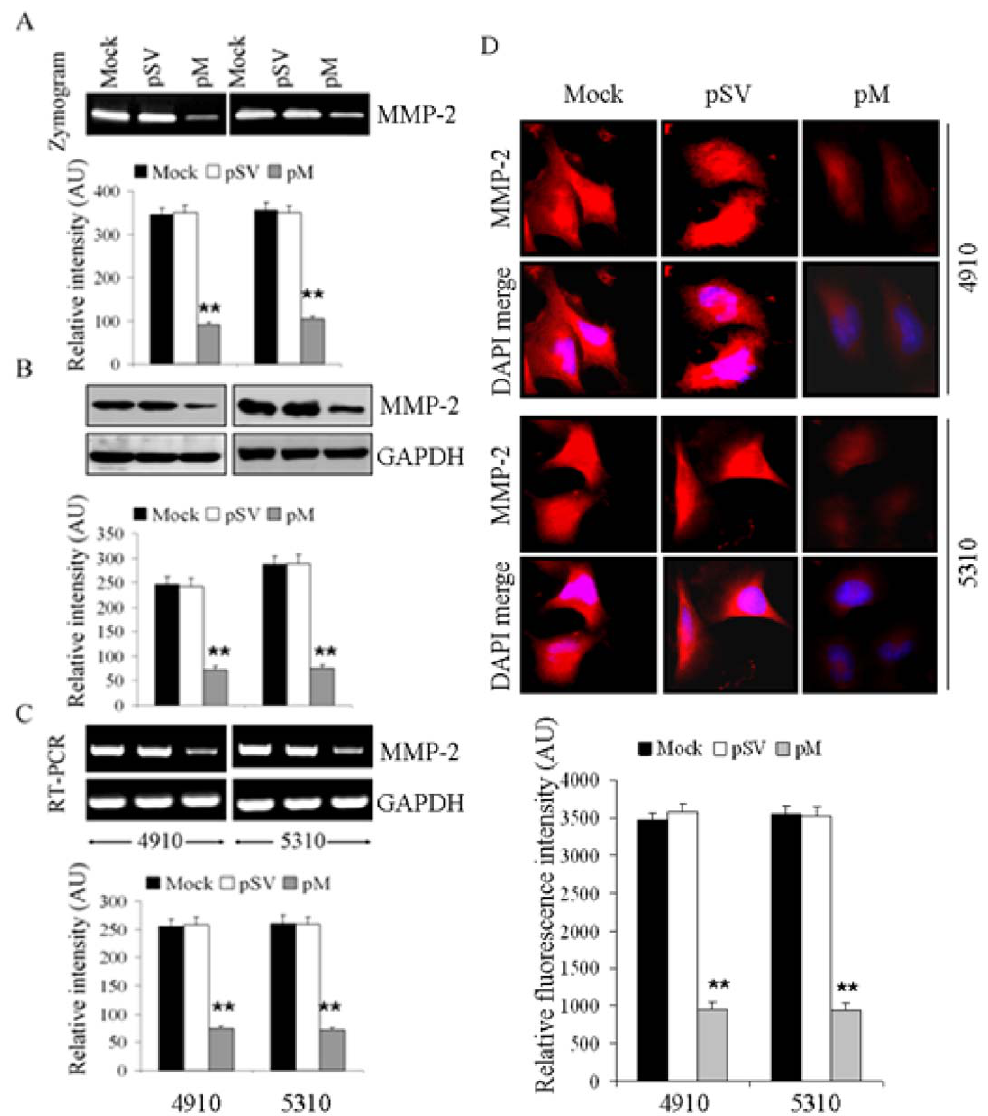
Figure 1. Effect of RNA interference on MMP-2 expression in human xenograft cell lines 4910 and 5310. Different treatments included control (mock), pSV (scrambled vector), pM (pMMP-2Si, pcDNA3.1 vector containing siRNA sequence for MMP-2). A. Gelatin zymography of extracellularly secreted MMP-2 in to tumor conditioned medium at 72 h post-transfection. The bar diagrams below represent the quantification of gelatinolytic band intensities in 4910 and 5310 cells with mean 6 SE of at least three individual experiments. B. Western blotting showing protein expression levels in mock, pSV and pM treatments. At 72 h post-transfection, cells were harvested and whole cell lysates were prepared using RIPA buffer. The representative blot of three different repetitions is shown. The blot was stripped and re-probed with anti-GAPDH antibody, which served as a loading control. The following bar diagram shows relative expression levels of MMP-2 protein with different treatments. C. Semiquantitative RT- PCR shows transcriptional levels of the MMP-2 gene and GAPDH was as a loading control. Band intensities were quantified using ImageJ 1.42 software (NIH Bethesda, USA) and the arbitrary units were plotted using mean 6 SE of at least three individual repetitions. D. Immunofluorescence study using blinded analysis showing the expression of MMP-2 in mock, pSV- and pM-treated 4910 and 5310 cells at 72 h post-transfection. After the treatments, cells were fixed in 4% paraformaldehyde, incubated with anti-MMP-2 antibody followed by Alexa Fluor H secondary antibodies, and observed under confocal microscopy. DAPI was used for nuclear counterstaining. Cells in randomly selected microscopic fields in three individual repetitions were represented where the fluorescence intensity was quantified using ImageJ and the arbitrary fluorescence units were plotted as mean 6 SE. The significant difference among different treatments in above experiments was represented by ‘‘**’’, at p , 0.01. cells was plotted in Fig. 2E, which shows up to 57.3 6 4.6% and 56.8 6 5.0% of the pM-transfected 4910 and 5310 cells were TUNEL-positive as compared to that of mock-treated (3.2 6 0.5% and 3.0 6 0.1%) and pSV-treated (3.3 6 0.36% and 2.8 6 0.5) cells, respectively. These results suggest that pM induced caspase- dependent apoptotic cell death. MMP-2siRNA treatments (data not shown). Among these we